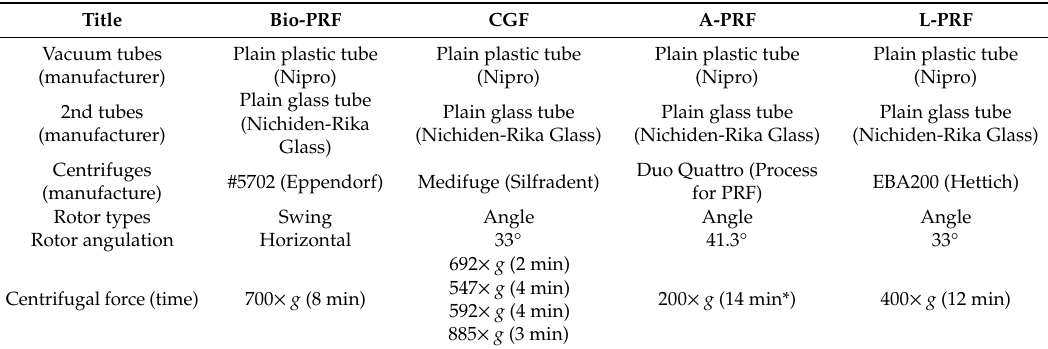
Figure 6. ( a ) Centrifuges used in this study. ( b ) The appearance of the corresponding PRF matrices in glass tubes after centrifugation. Table 1. Devices and centrifugal conditions for preparation of individual PRF matrices.